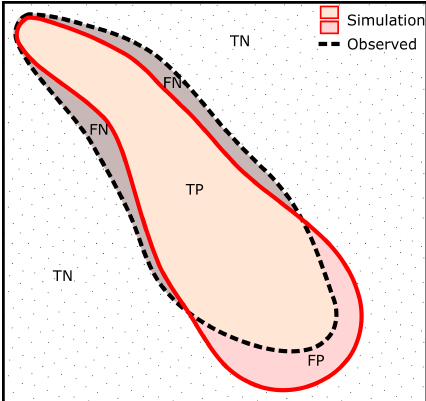
Figure 4. Illustration of confusion matrix classification for simula- tion performance assessment. Dashed black outline represents the observed flow outline, and solid red outline represents the simu- lated flow outline. Areas outside of both simulated and observed flow outlines are classed as true negatives (TNs, dotted region); ar- eas outside simulated outline but inside observed outline are classed as false negatives (FNs); areas inside both simulated and observed outline are classed as true positives (TPs); and areas inside simu- lated outline but outside observed outline are classed as false posi- tives